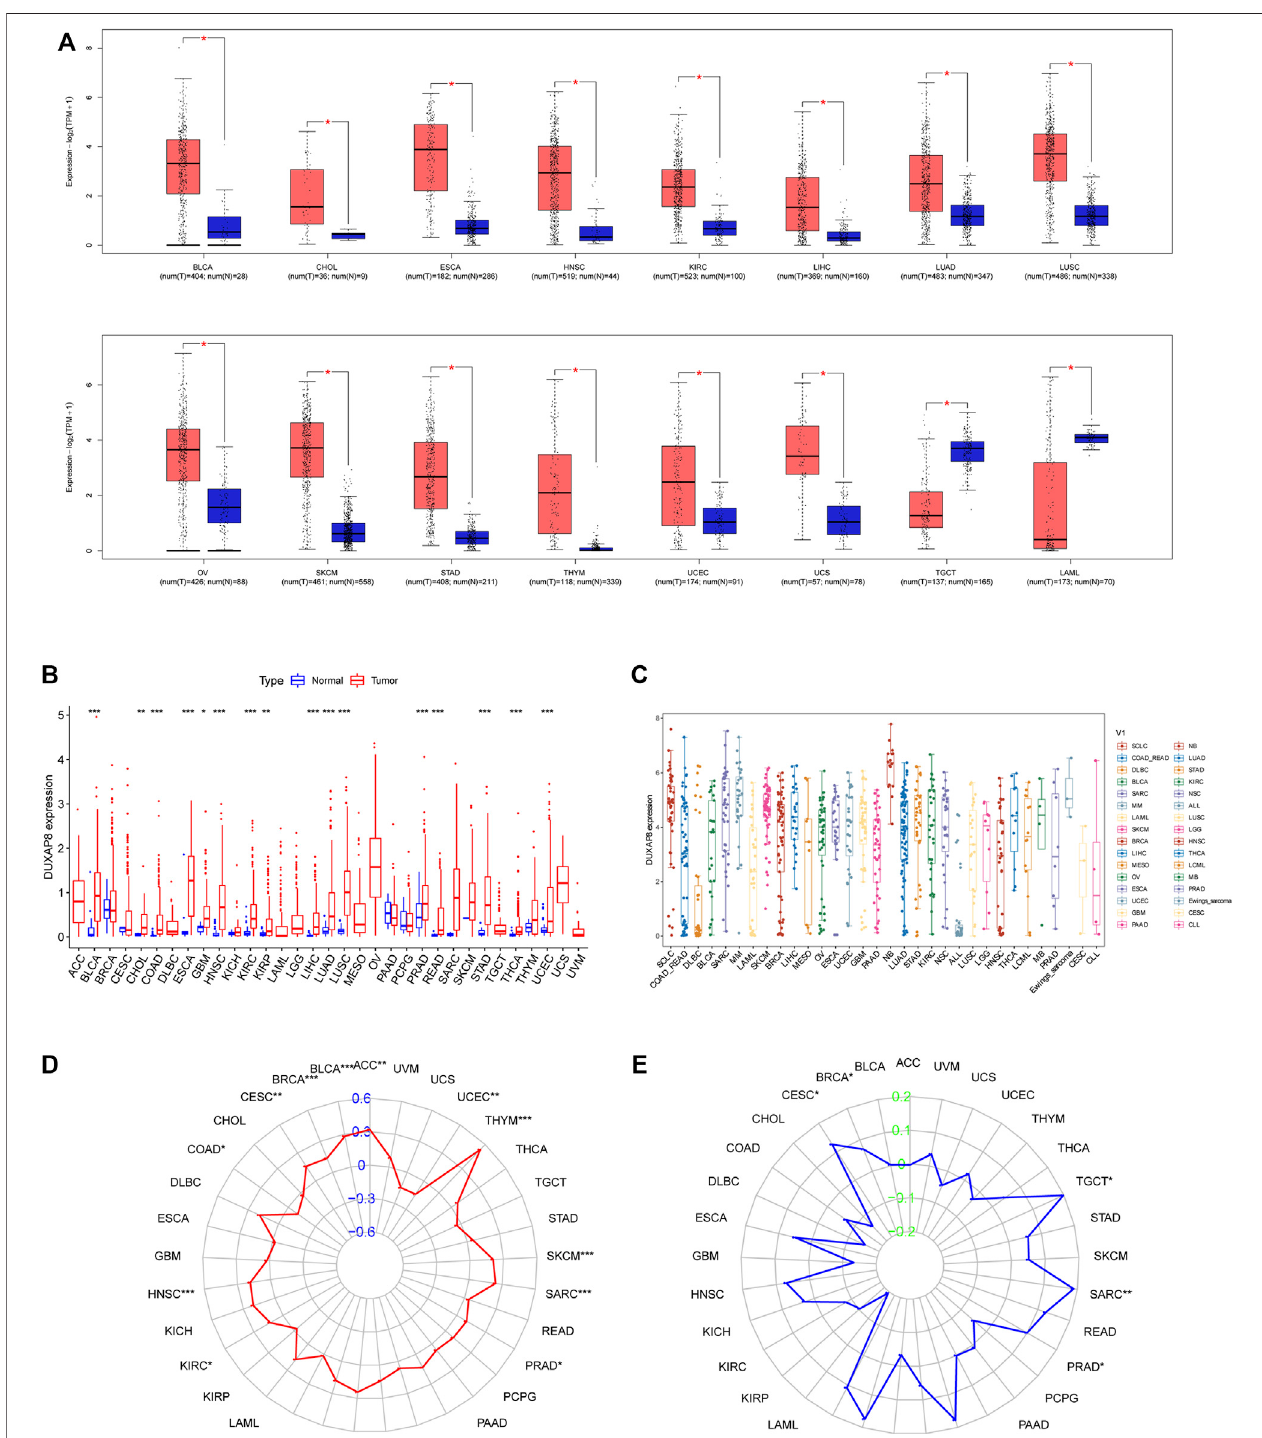
FIGURE 6 | (A) DUXAP8 expression levels in different cancer types from TCGA data by Gene Expression Pro fi ling Interactive Analysis (GEPIA). (B) DUXAP8 expression levelsindifferentcancertypes fromTCGAdata.Thered fusiformisrepresents tumortissueandthebluefusiformisrepresentsnormaltissue. p < 0.05, < 0.01, < 0.001 arerepresented by “ * ” , “ ** ” , “ *** ” respectively. (C) The expression distribution of DUXAP8 indifferenttumor tissues. (D) The radarchartillustratedtheassociation between TMB and DUXAP8 expression in different cancers. (E) The radar chart illustrated the relationship between MSI and DUXAP8 expression in different cancers. The blue curve represents the correlation coef fi cient, and the green value represents the range.